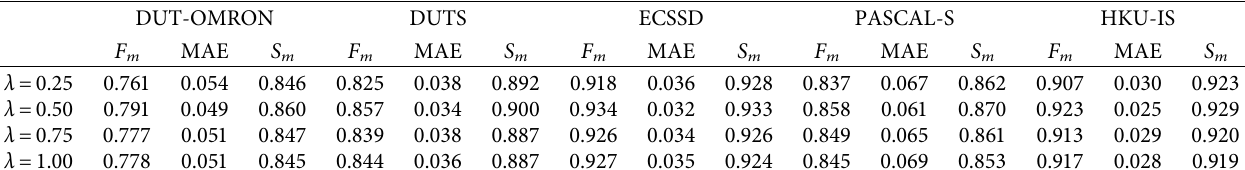
Table 3: Comparison with different λ . When λ � 0.50, the proposed model achieves the best results.